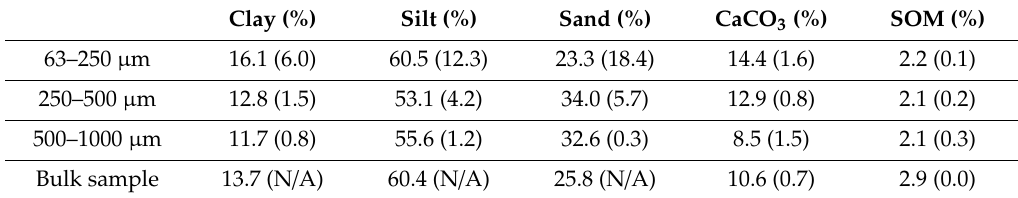
Table 1. Mean values of soil properties for the reference samples and the bulk sample.